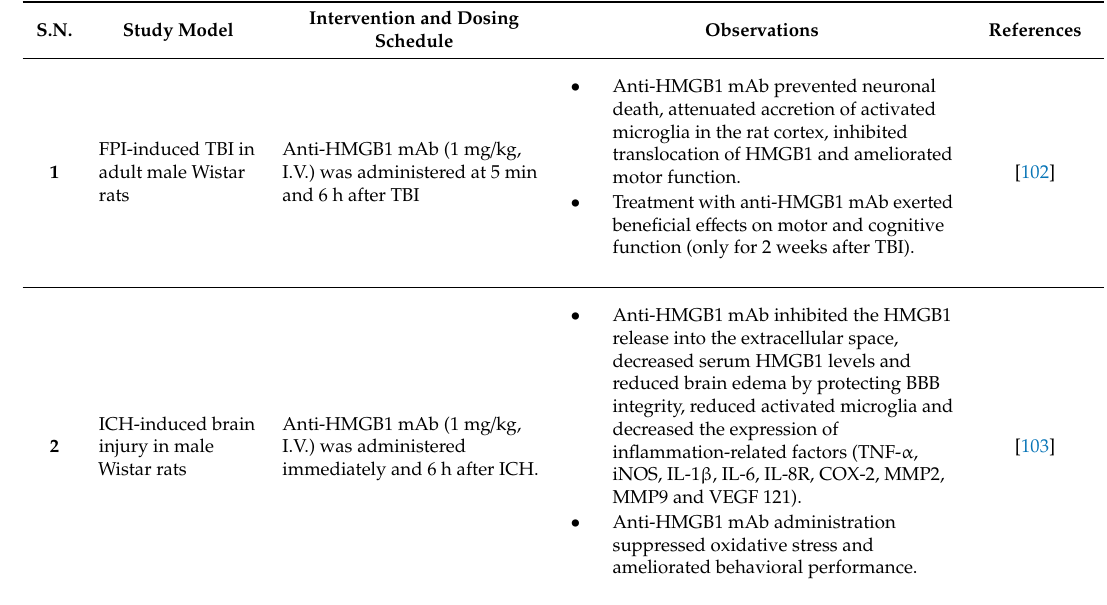
Table 3. Studies targeting HMGB1 in